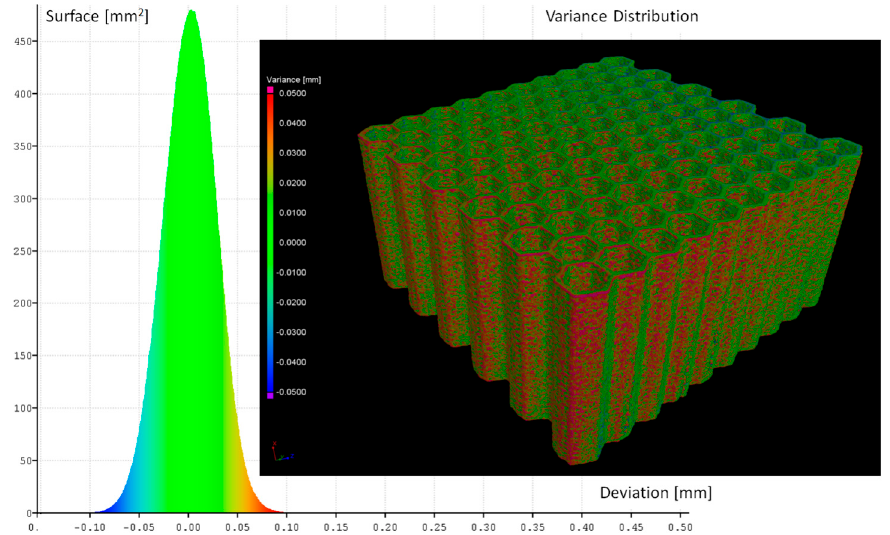
Figure 6. Geometrical quality control of specimen No. 1 before versus after heat treatment.